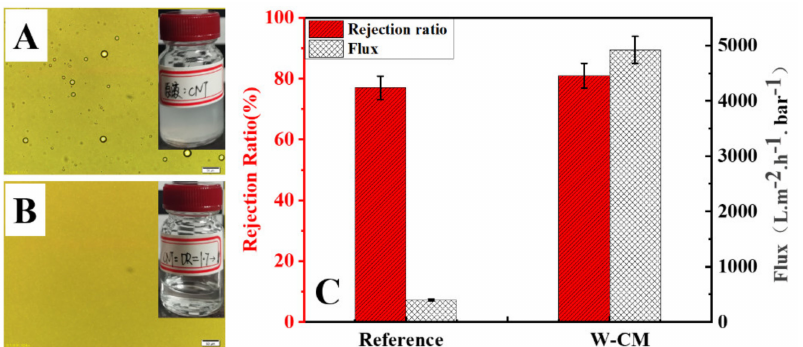
Figure 2. POM images of water-in-oil emulsion before ( A ) and after separation ( B ). ( C ) shows the flux and rejection ratio during the separation of water-in-oil emulsion. Insets in ( A , B ) are the corresponding